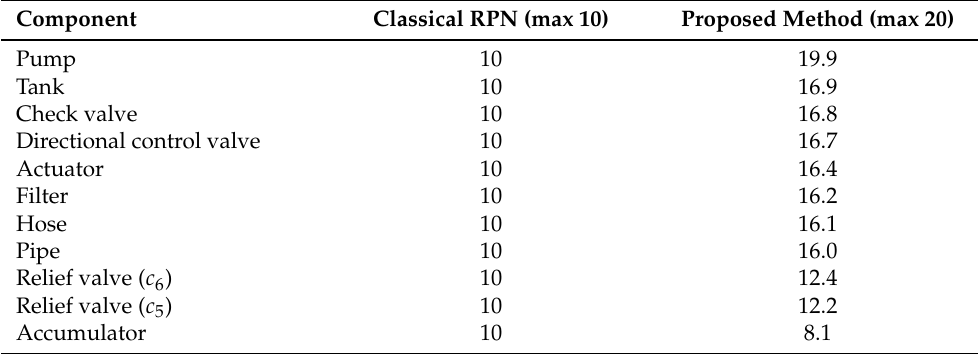
Table 7. Severity